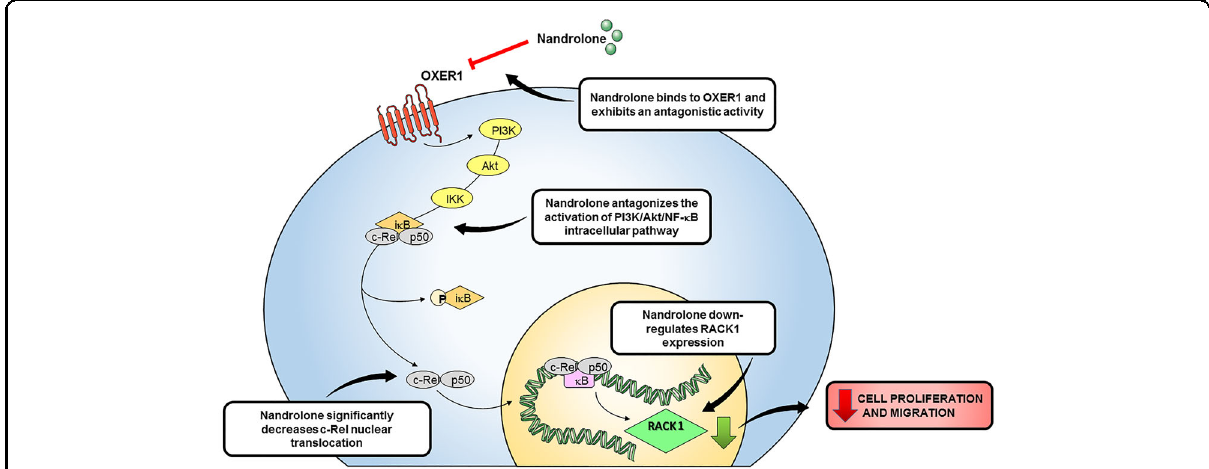
Fig. 7 Schematic representation of nandrolone-antagonizing effects on OXER1-initiated pathwaw in BC cells. The binding of nandrolone to OXER1 antagonizes the PI3K/Akt/NF- κ B pathway leading to a signi fi cant decrease of c-Rel nuclear translocation through a strong decline in RACK1expression, which inhibits cell proliferation and mi-initiated PI3K/Akt/ NF- κ B pathway and RACK1 expression in BC cells (see text for more